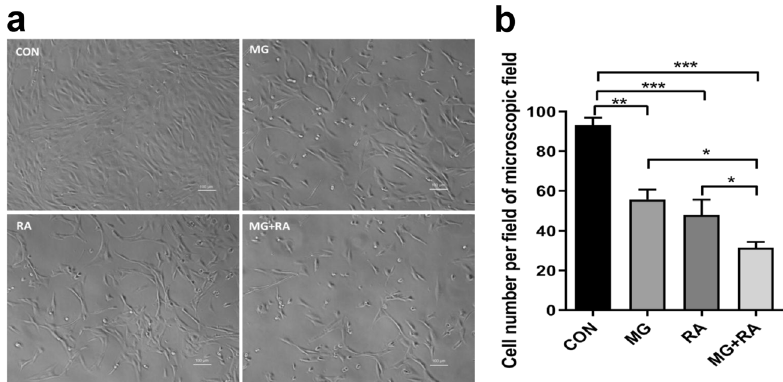
Fig. 1 The combination of clinorotation and X-ray radiation decreased the survival of MC3T3-E1 cells as evidenced by cell counting results. a Representative images of MC3T3-E1 cells in the four groups (scale bars, 100 µm). b The number of surviving cells in the four groups ( n = 4). The data are expressed as the mean ± SD. * P < 0.05, ** P < 0.01, *** P < 0.001, ns not signi fi cant.